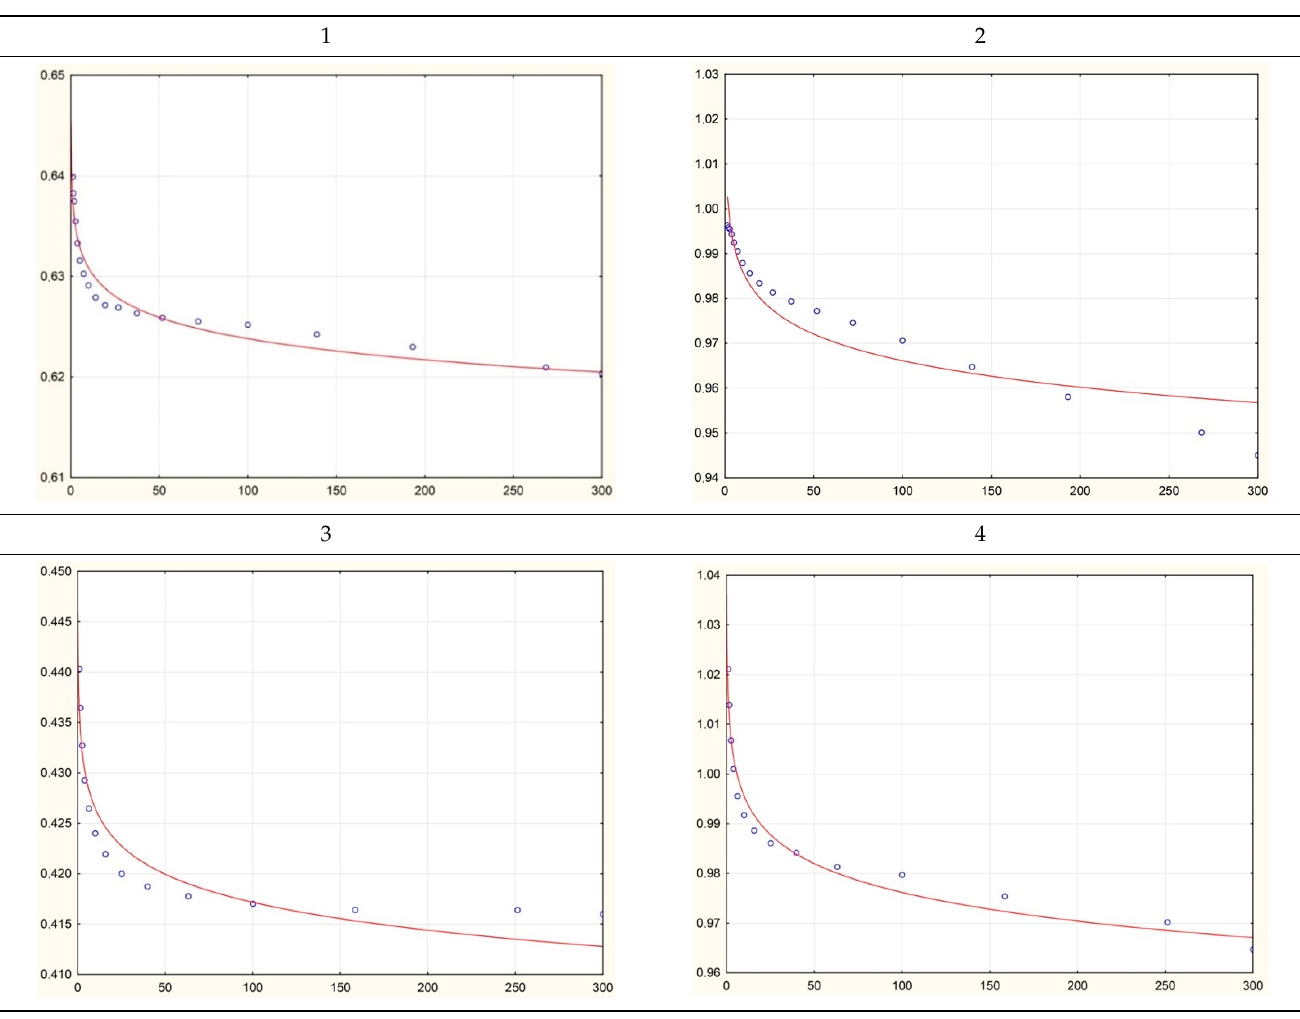
Table 10. Graphical representation of the dynamic viscosity coefficient dependence on the shear rate gradient (*—dynamic viscosity coefficient dependence on shear stress).